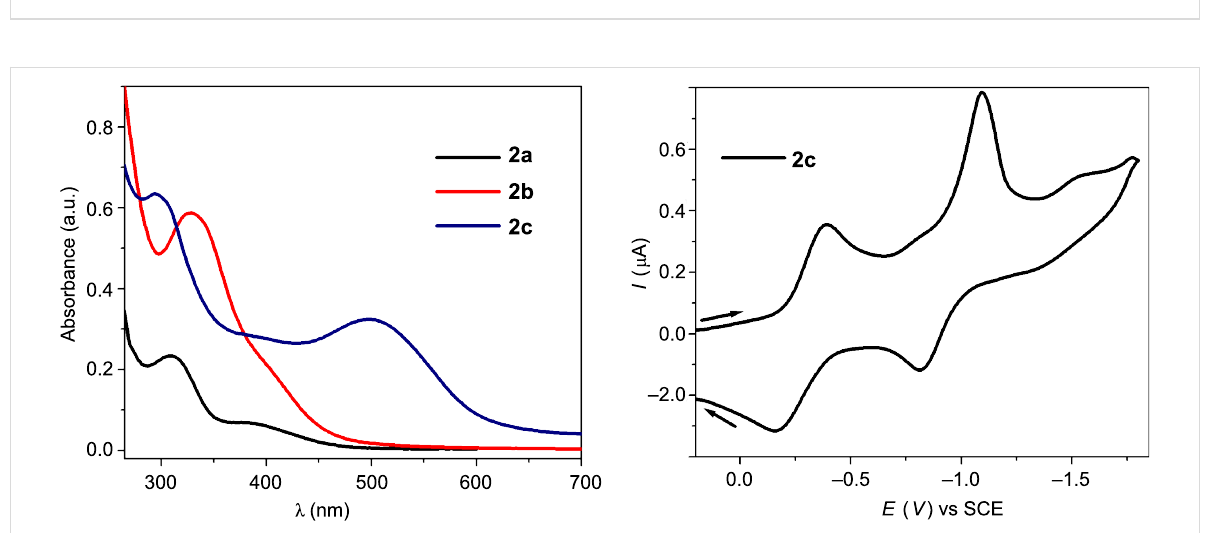
Figure 6: UV–vis absorption spectrum (left) of macrocycles ( 2a – 2c ) recorded in CH 3 CN at 298 K, and cyclic voltammogram of 2c (right) performed in CH 2 Cl 2 /0.1 M ( n -Bu) 4 NPF 6 with a scan rate of 100 mV s − 1 versus SCE at 298